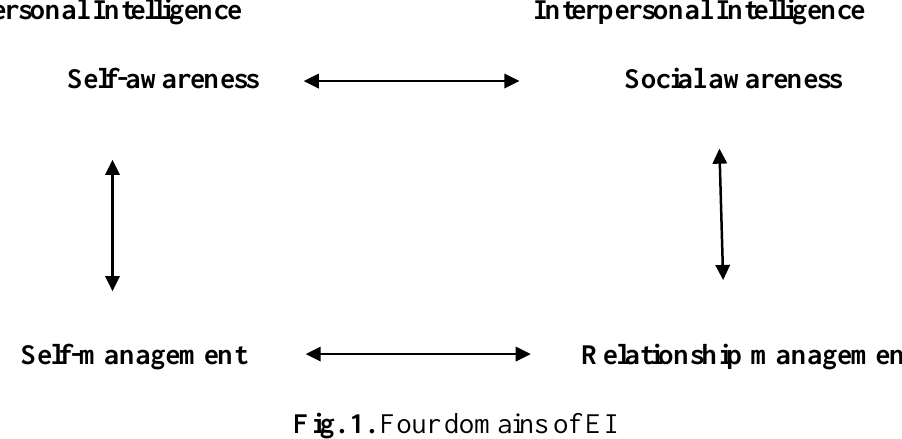
Fig. 1. Four domains of